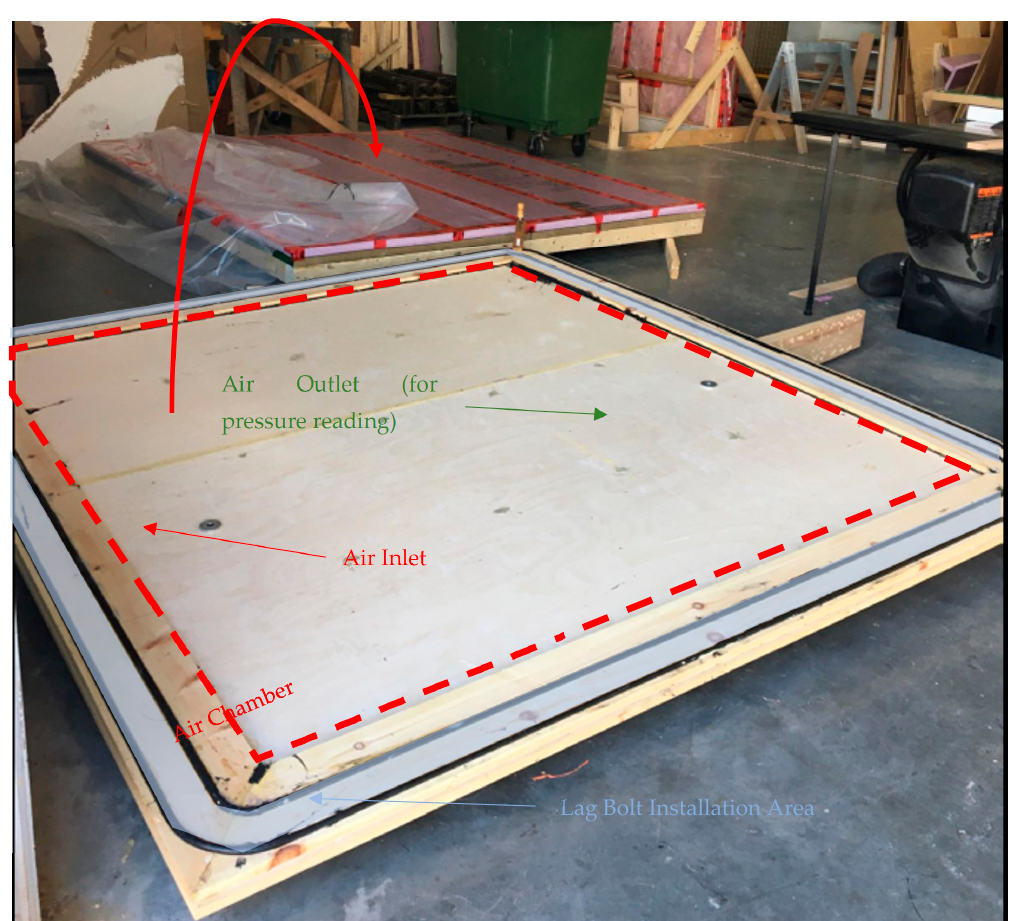
Figure 4. The sealed box that was used for the airtightness testing. The box was attached to the wall assembly using lag bolts and rubber washers. An air outlet and air inlet were installed to allow air to enter the air chamber and to measure the pressure in the chamber.